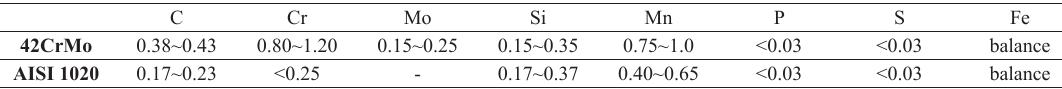
Figure 1. Schematic representation of the HCSPN Table 1. Chemical composition (wt %) of 42CrMo steel and AISI1020 steel used in the present work.